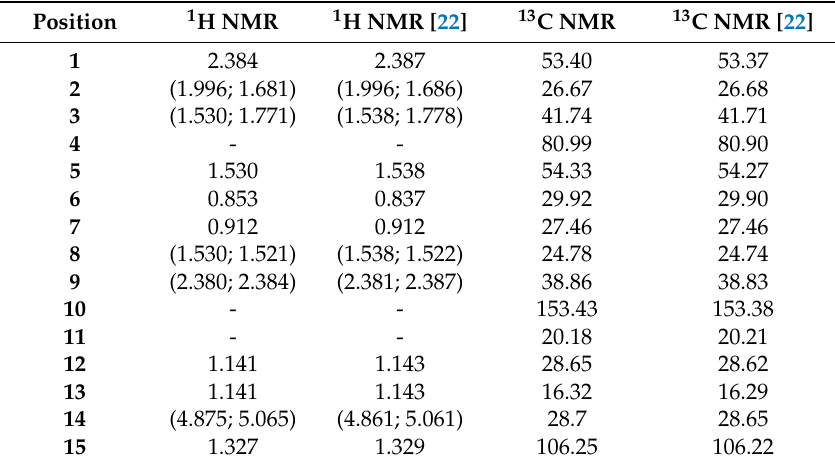
Table 8. NMR data of Spathulenol substance (S 38) compared to literature data.